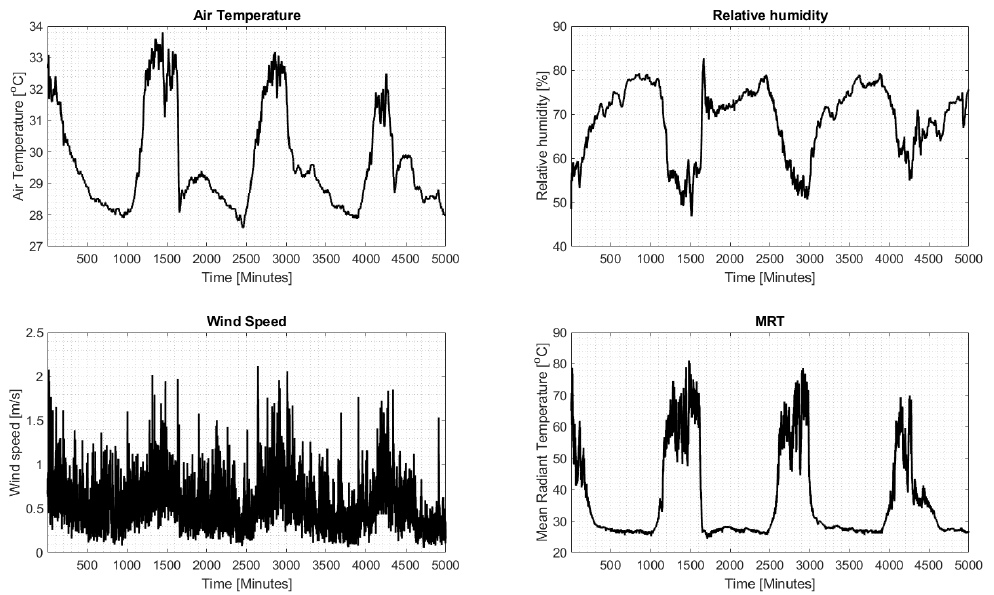
Figure 3. Four climatic variables time series over 5000